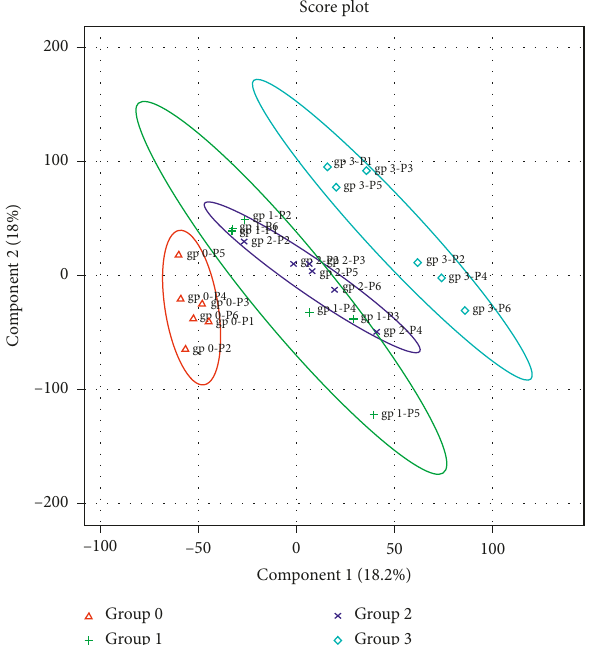
Figure 2: Two-dimensional (2D) partial least squares discriminant analysis separation using protein normalized spectral abundancy factor count-based proteomic measurements in the urine exosome of healthy controls (group 0), patients with compensated cirrhosis (group 1), with decompensated cirrhosis (group 2), and with decompensated cirrhosis and kidney injury (group 3). Clear separation of urine exosome proteins for control versus cirrhotics is observed, signified by the lack of overlap between the two groups of exosome proteins. However, among the cirrhotic subjects, the observed overlap between groups 1 and 2 may be due to crowding, as the expansion of the axes magnitude showed sufficient delineation.